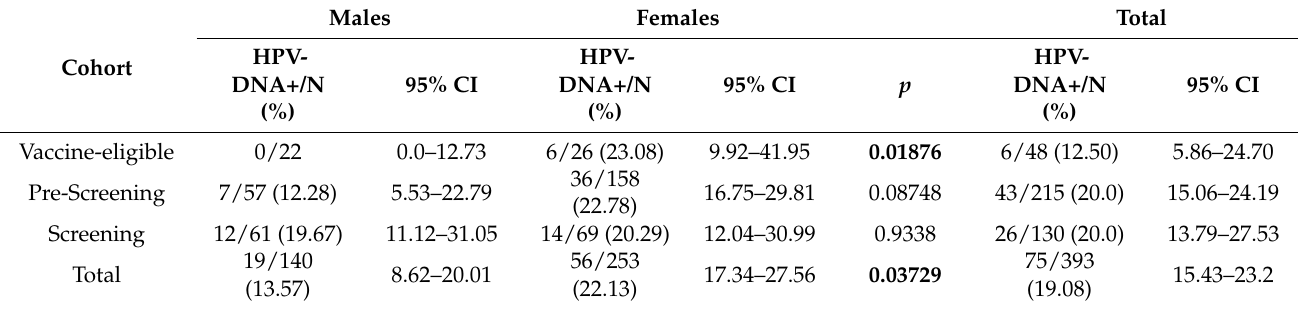
Table 2. Prevalence of positive subjects, broken down by gender and cohort: vaccine-eligible cohort (born between 1997 and 2001), pre-screening cohort (born between 1991 and 1996) and screening cohort (born before 1990). A significant p -values are indicated in bold (significance considered p <